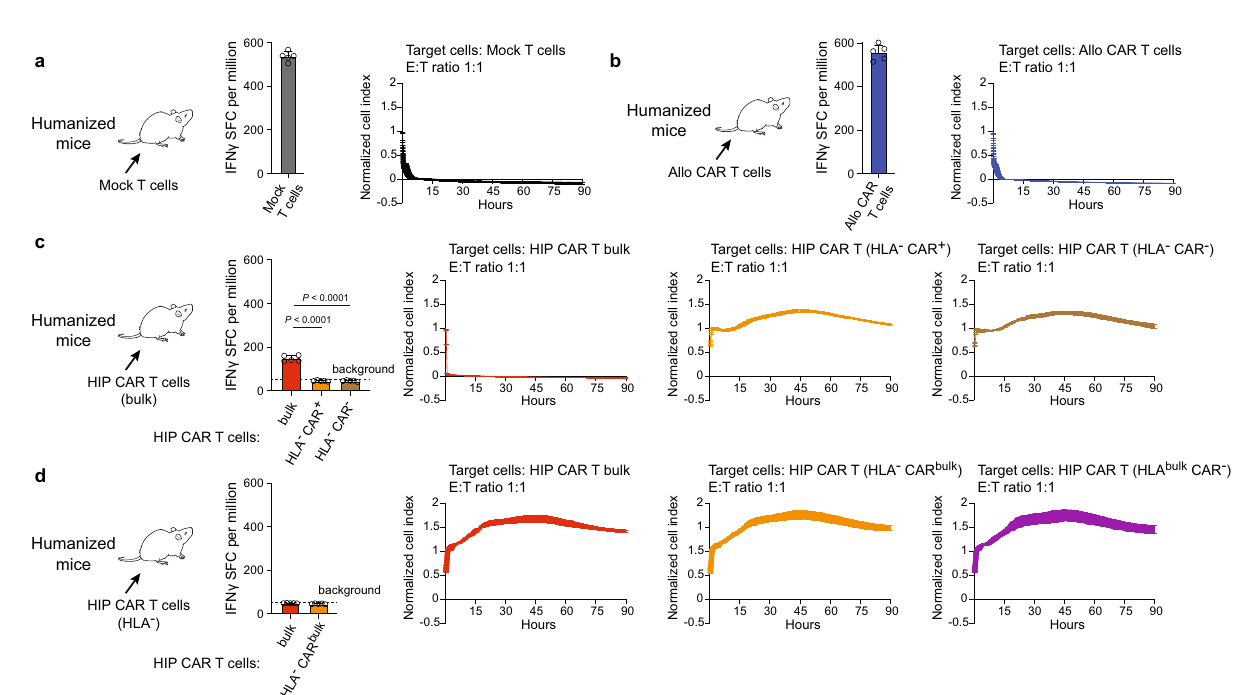
Fig. 5 | The CD47-targeting safety strategy for HIP CAR T cells. a , b HIP CAR T cells were challenged with NK cells ( a ) or macrophages ( b ) in the presence and absence of SIRP α -Fc IgG1 or IgG4, or a SIRP α with poly-His tail (upper rows, three independent replicates per group and time point). Effector cell Fc was blocked by Fc block solution (lower rows, three independent replicates per group and time point in one experiment). c Immunode fi cient NSG mice were injected with 1×10 6 Luc + Nalm6 cells and received 3×10 6 HIP CAR T cells or Mock T cells on day 3. In two HIP CART groups, miceadditionally received three doses of the SIRP α -FcIgG1 or IgG4 on days 3, 4, 5, and 8. Spleen and bone marrow were taken after 27 days. d BLI images show the tumor burden for all mice in this study. e Graphs show